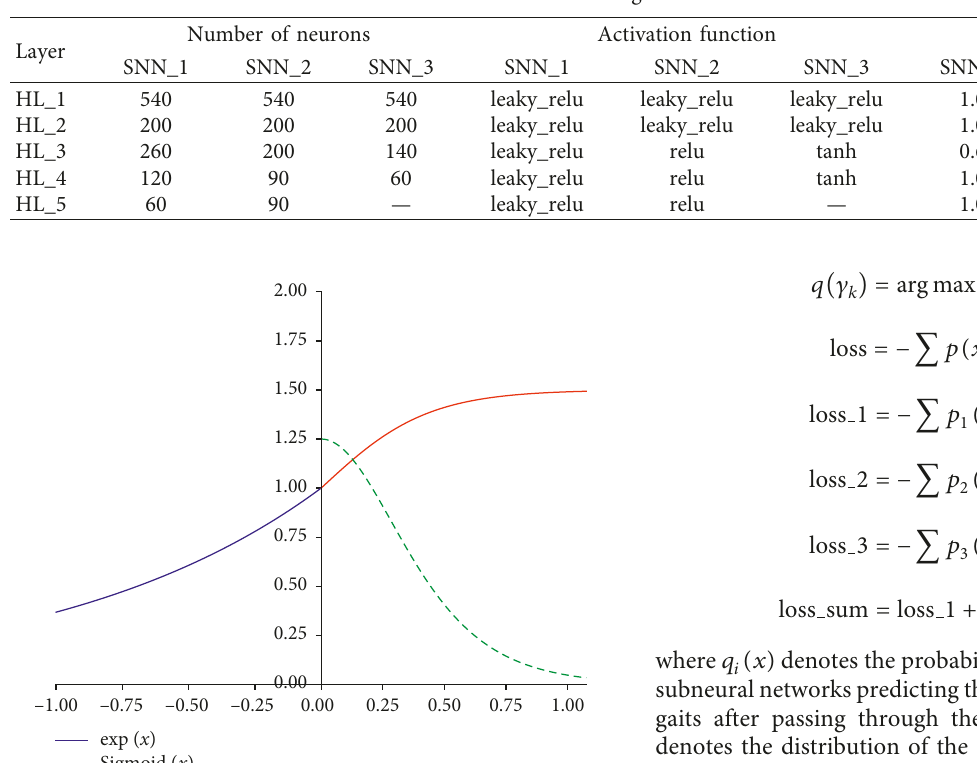
Table 2: Parameter setting of VWI-DNN structure.